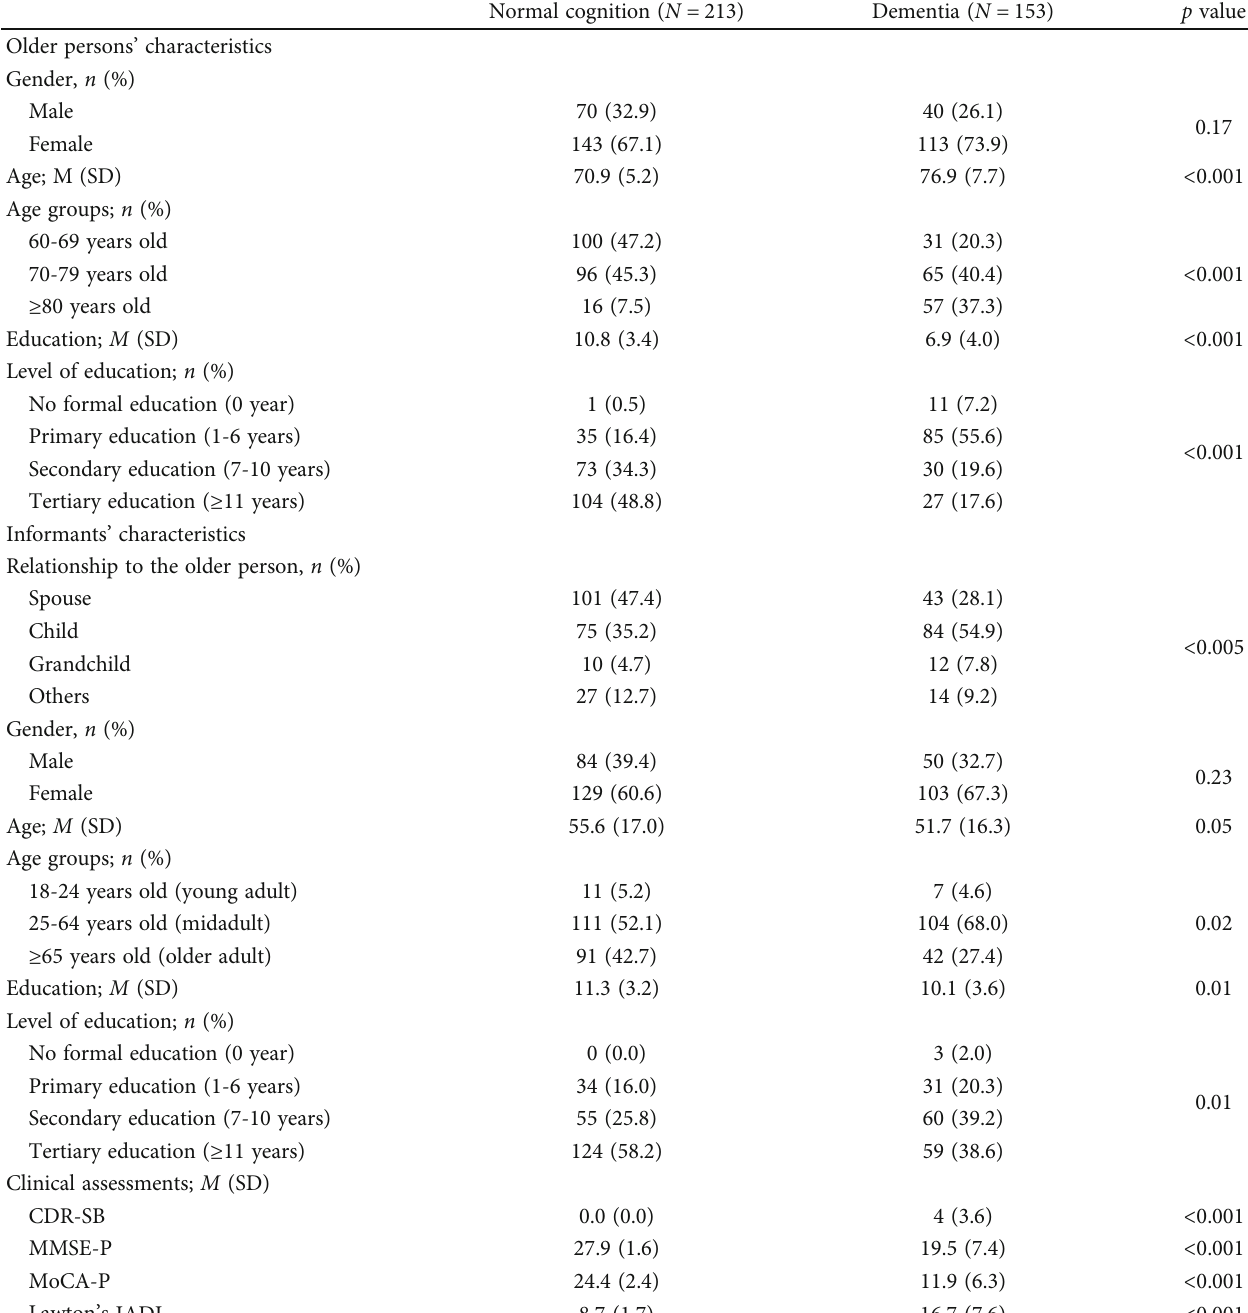
Table 1: Characteristics of study